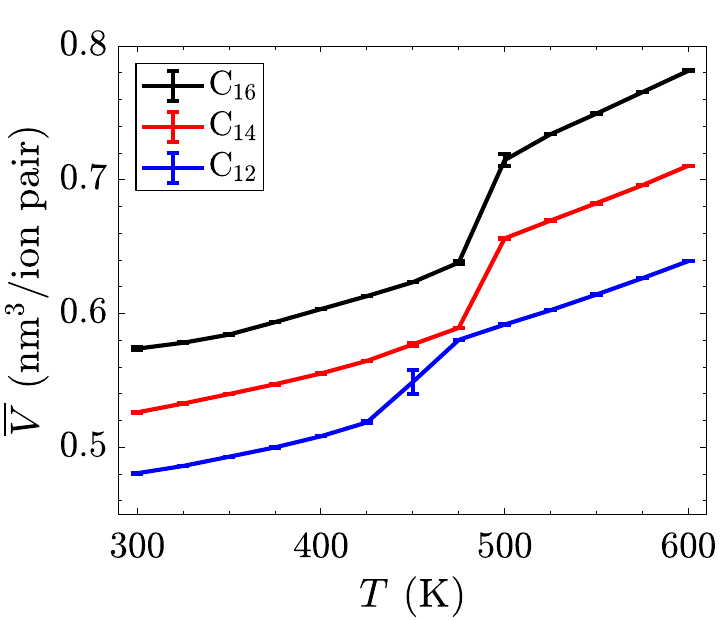
Figure 4. Intrinsic volume per ion pair as a function of temperature for three different alkyl chain lengths. The most dramatic jump in volume is between the crystalline and smectic phases. The transi- tion between the smectic and isotropic phases is not apparent in this quantity. Transition temperatures are summarized in Table